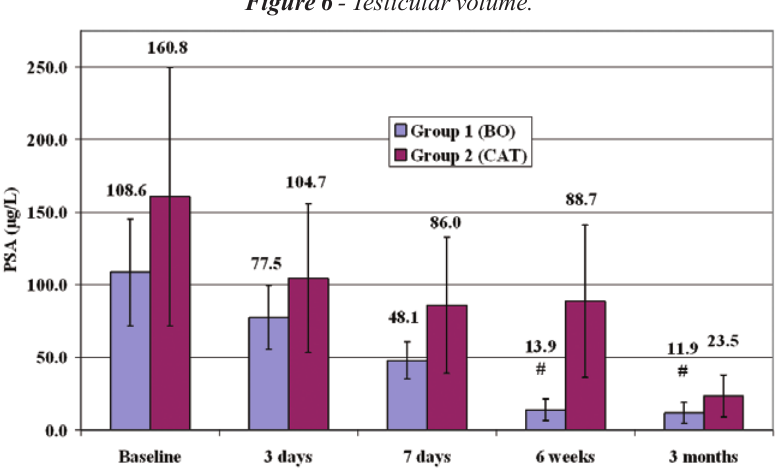
Figure 6 - Testicular